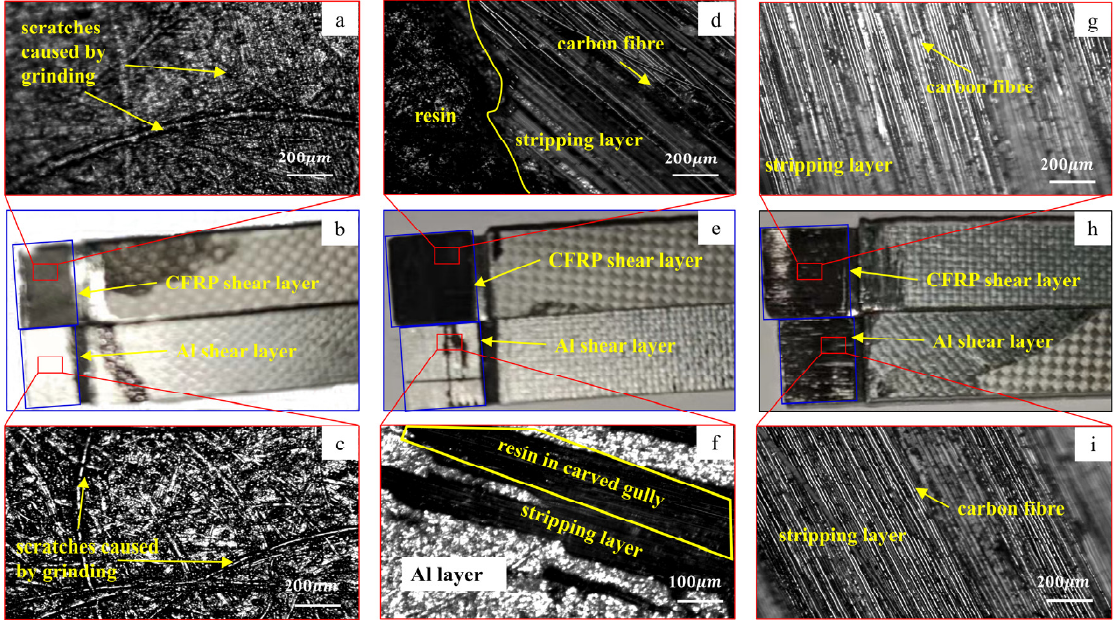
Figure 9. Shear failure morphologies of Al/CFRP bonding surfaces after different interface treatments.